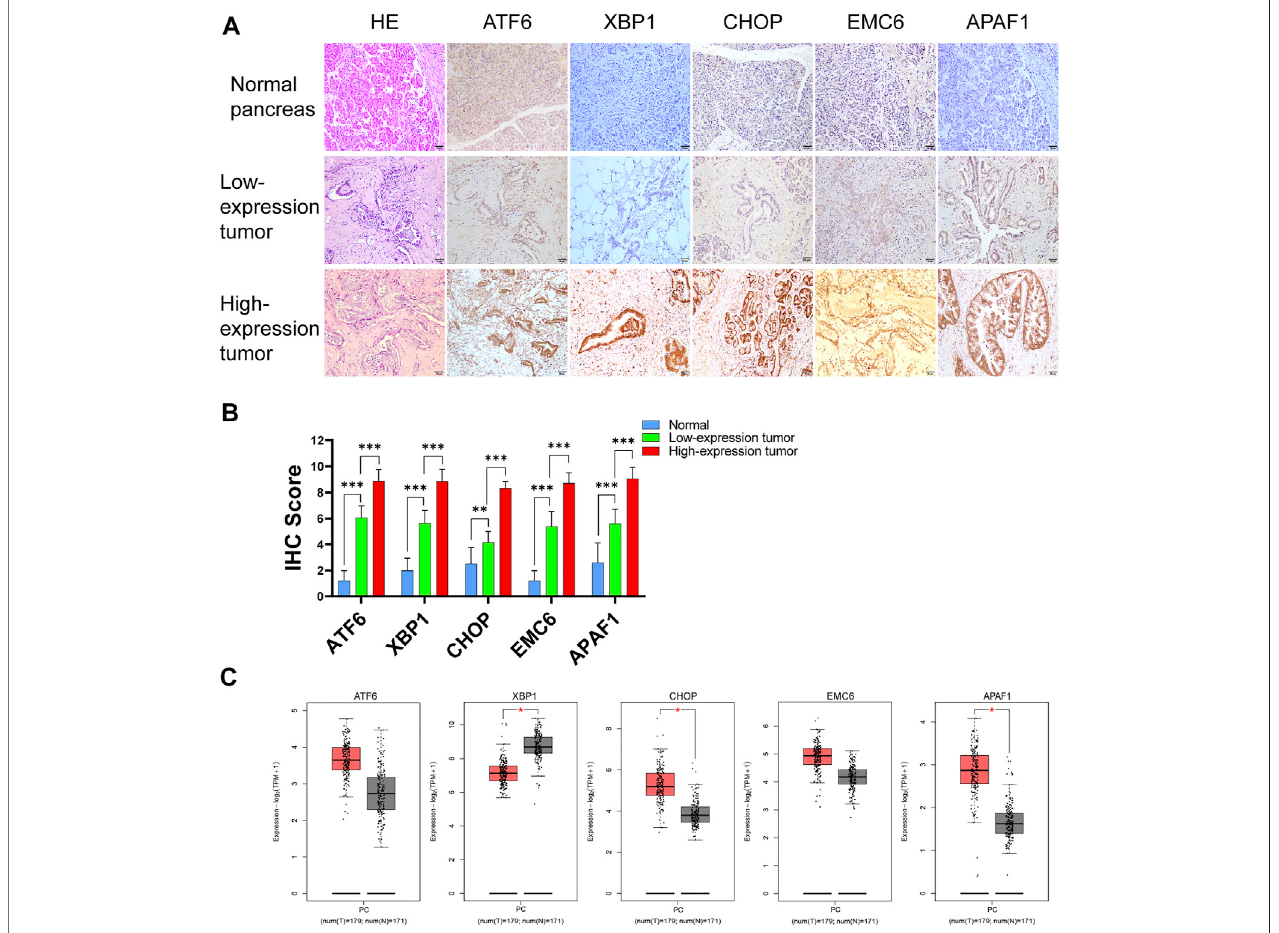
FIGURE 1 | Analysis of ATF6, XBP1, CHOP, EMC6, and APAF1 expression in tumor and adjacent normal tissue samples of human. (A) H&E staining and immunohistochemical detection of ATF6, XBP1, CHOP, EMC6, and APAF1 protein expression in pancreatic tissue from normal and PC patients. (B) The expression of ATF6,XBP1,CHOP,EMC6,andAPAF1intumorandnormalsamples. (C) TheexpressionofATF6,XBP1,CHOP,EMC6,andAPAF1intumor(red)andnormalsamples (gray) via GEPIA2.T,tumors;N,normaltissues;* p ≤ 0.05,** p ≤ 0.01,*** p ≤ 0.001.Scalebars=50 μ m.ATF6,transcriptionfactor6;XBP1,X-box-bindingprotein1; CHOP, C/EBP homologous protein; EMC6, ER membrane protein complex subunit 6; APAF1, apoptotic protease-activating factor 1; H&E, hematoxylin and eosin; PC, pancreatic cancer; GEPIA2, gene expression pro fi ling interactive